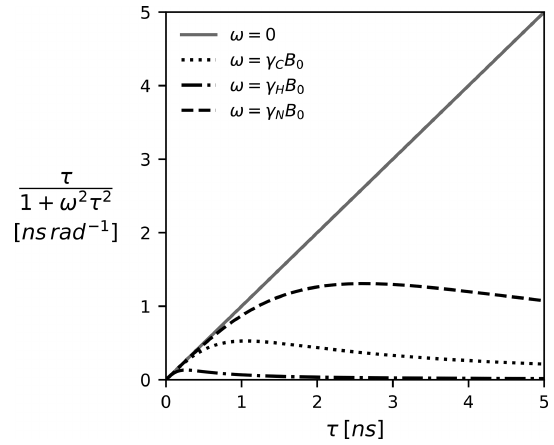
Figure 1. The Lorentzian as a function of the correlation time τ and the (Larmor) frequency. The spectral density J ( ω ), which is modeled as a linear combination of Lorentzian functions, can be pictured as a weighted average of all correlation times τ . Since J (0) weights all correlation times equally, it represents the component most sensitive to correlation times > 1ns. The magnetic field B 0 is 18.8T (800MHz proton Larmor